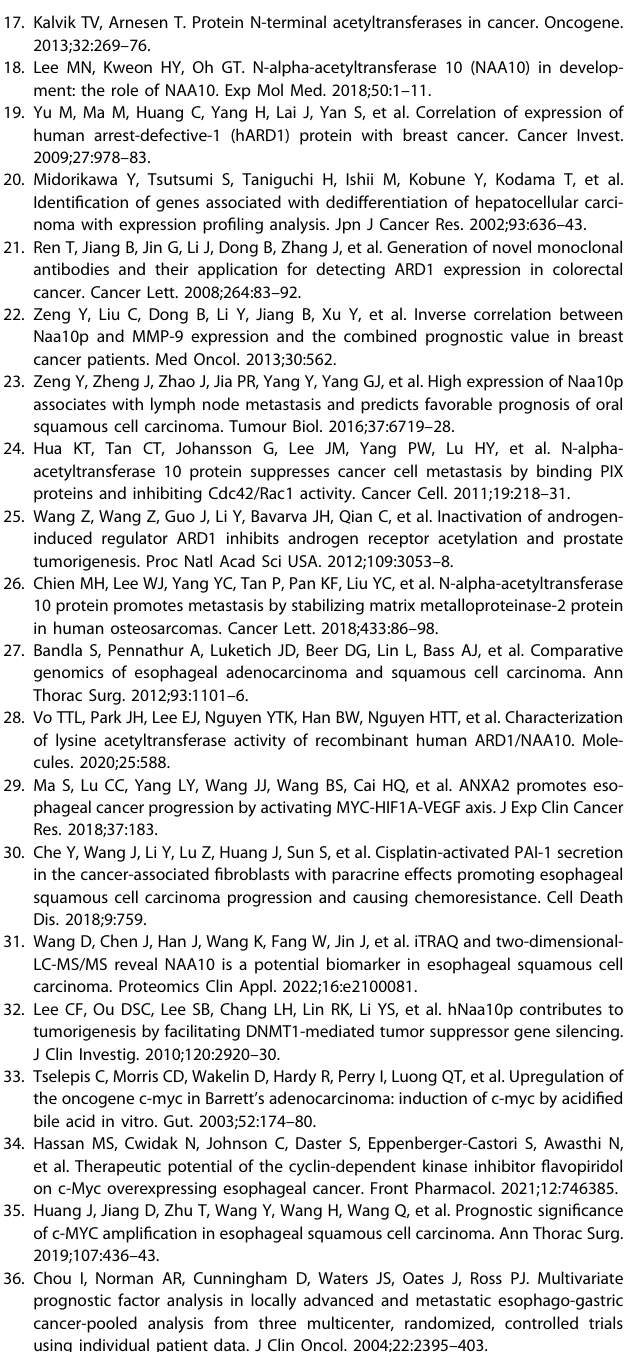
Fig. 8 Naa10p associates with PAI1 to regulate cell invasiveness of ESCA cells. A Stably Naa10p-V5-expressing KYSE70 cells were immunoprecipitated with an V5 antibody and blotted with anti-PAI1 and anti-Cystatin E/M antibody. B KYSE70 cells were immunoprecipitated with Naa15 antibody and blotted with anti-Naa10p and anti-PAI1 antibody. C KYSE70 cells with stable Naa10p knockdown were transfected with either Naa10p-V5 or Naa10p-R82A-V5. Cell extracts were immunoprecipitated with an anti-PAI1 antibody or anti-acetylated lysine antibody and blotted with anti-acetylated lysine and anti-PAI1 antibody. D KYSE70 cells with stable Naa10p knockdown were transfected with either Naa10p-V5 or Naa10p-R82A-V5. Cell extracts and conditioned medium of these cells were collected and immunoblotting analysis was performed. E Cell extracts and conditioned medium of KYSE70 cells receiving sh NAA15 or control shRNA were collected and immunoblotting analysis was performed. F Immunoblotting analysis of stably c-Myc-silencing KYSE70 cells transfected with either Ctl-shRNA or SERPINE1 shRNAs. G Quantitative data comparing cell invasion of stably c-Myc-silencing KYSE70 cells transfected with either Ctl-shRNA or SERPINE1 shRNAs. Bars are the mean ± SD of three independent experiments. ** P < 0.01 when compared to shCtl group and ## P < 0.01 when compared with sh MYC -shCtl cells by two-tailed Student ’ s t test. Scale bar: 100 μ m. H Kaplan – Meier plot of overall (OS) survival of ESCA patients strati fi ed by NAA10 and SERPINE1 expression level. A log rank test was used to show differences between